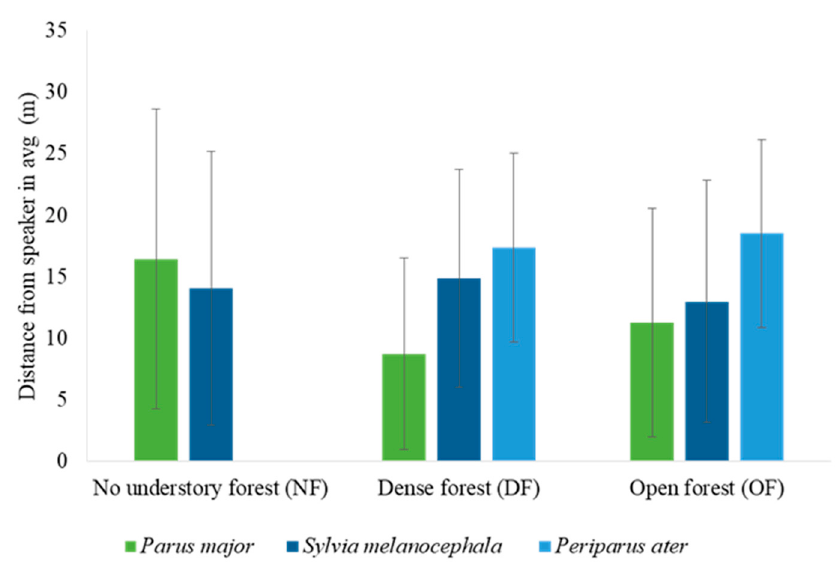
Figure 6. Distance from speaker (mean ± SD) of individual responders to the playbacks of three different caller species in three forest habitats (pooled across seasons).